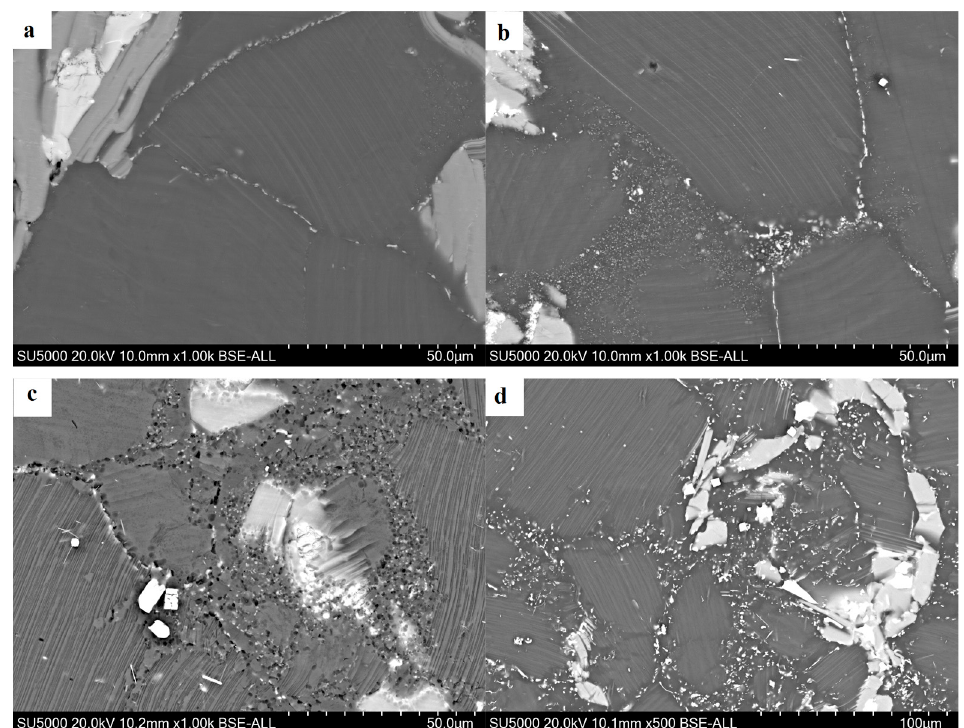
Figure 4. ( a – d ) Backscattered electron (BSE) image of strain rates of 0.5 s − 1 , 0.1 s − 1 , 0.01 s − 1 , and 0.001 s − 1 , respectively.